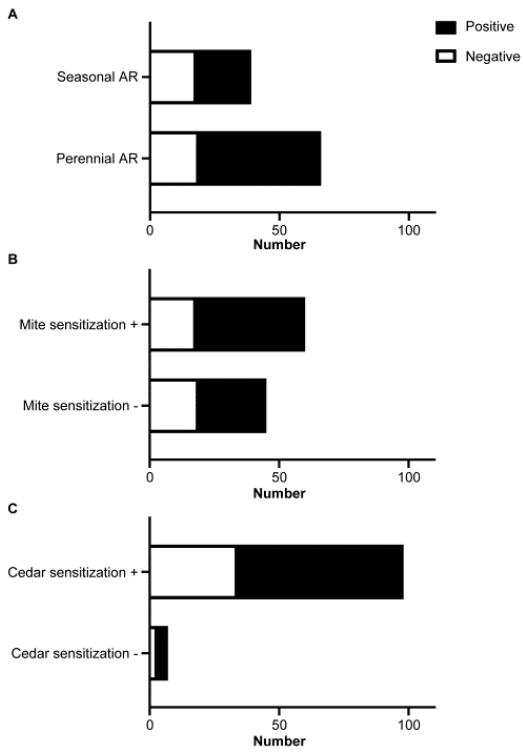
Figure 4. Association between the total IgE in nasal fluid by the AW test and AR phenotypes: ( A ):